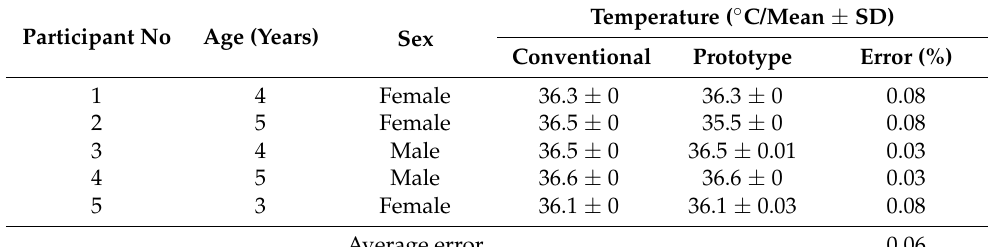
Table 2. Results of body temperature measurement using conventional tools and prototype of an- thropometric system.